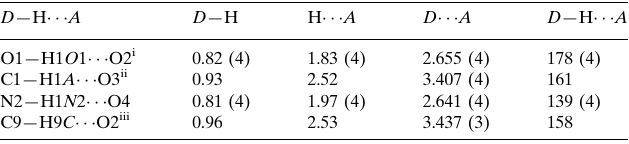
Hydrogen-bond geometry (A˚ , (cid:2)